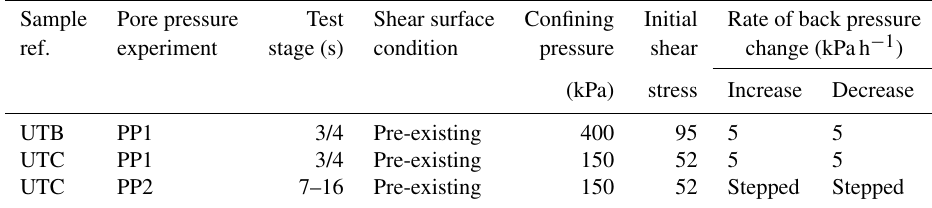
Table 2. Summary of pore pressure reinflation experiment parameters. Sample Pore pressure Test Shear surface Confining Initial